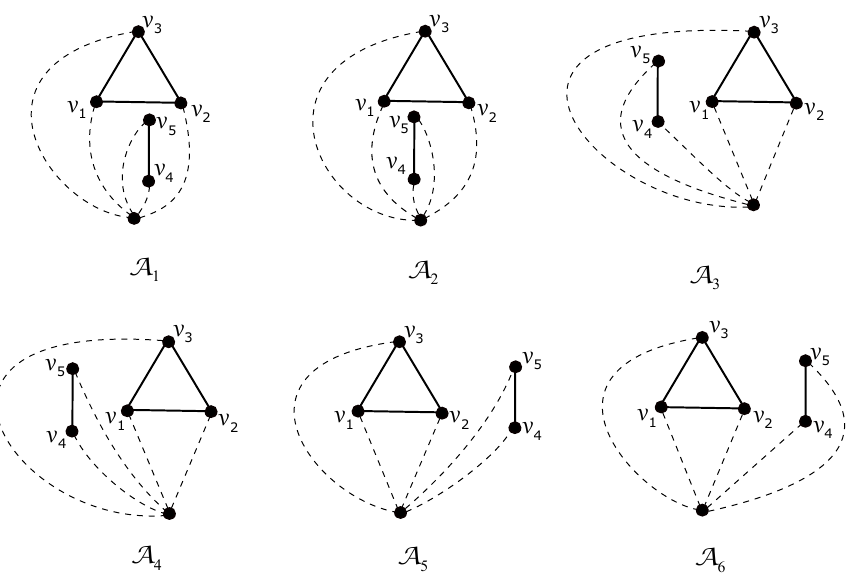
Figure 2. Drawings of six possible configurations A k of subgraph F i = G ∗ ∪ T i for T i ∈ R D .